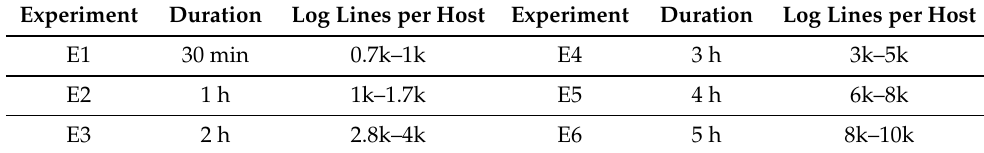
Table 5. Multihost Experiment Timeframe.